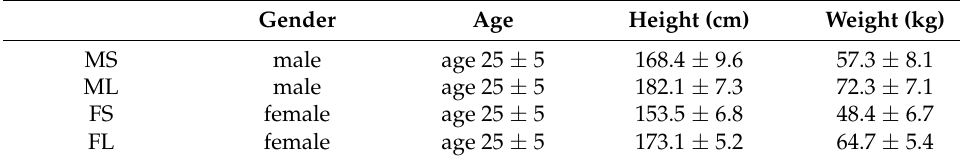
Table 9. Details of experiment